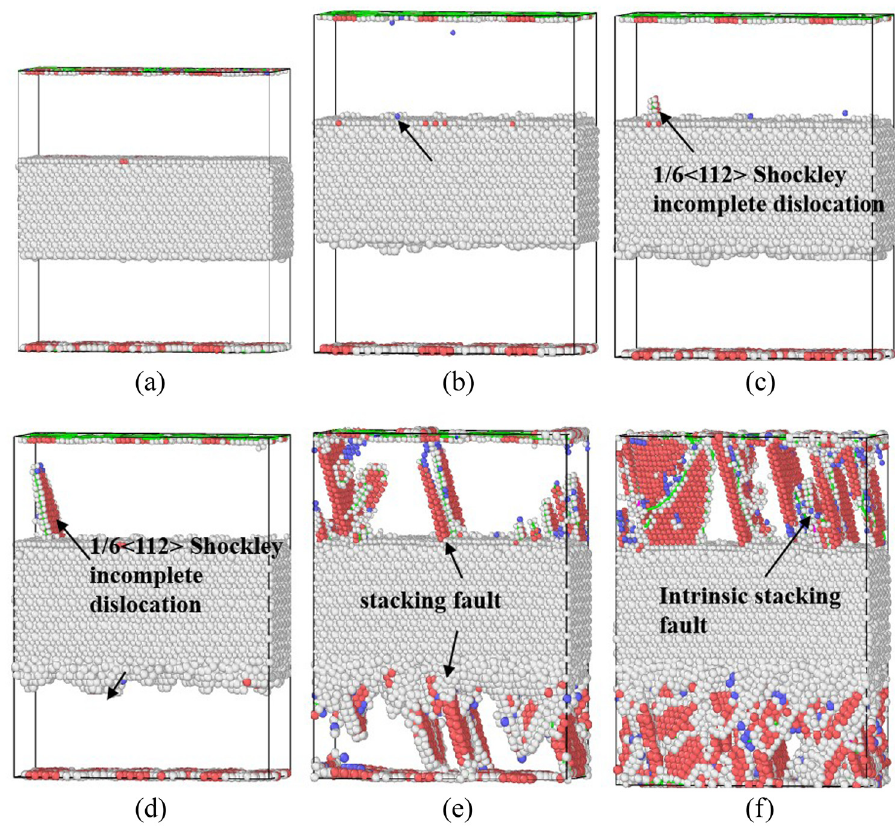
Figure 3: The Cu ( 111 ) /Al 2 Cu ( 1¯ 10 ) /Al ( 111 ) interface con fi gurationcorrespondsto the mark point atthe fi rst stageinthe tensilestress – strain curve ( Figure 2 ) . ( a ) ε = 0 ( point A ) , ( b ) ε = 0.068 ( point B ) , ( c ) ε = 0.072 ( point C ) , ( d ) ε = 0.085 ( point D ) , ( e ) ε = 0.097 ( point E ) , ( f ) ε = 0.107 ( point F )